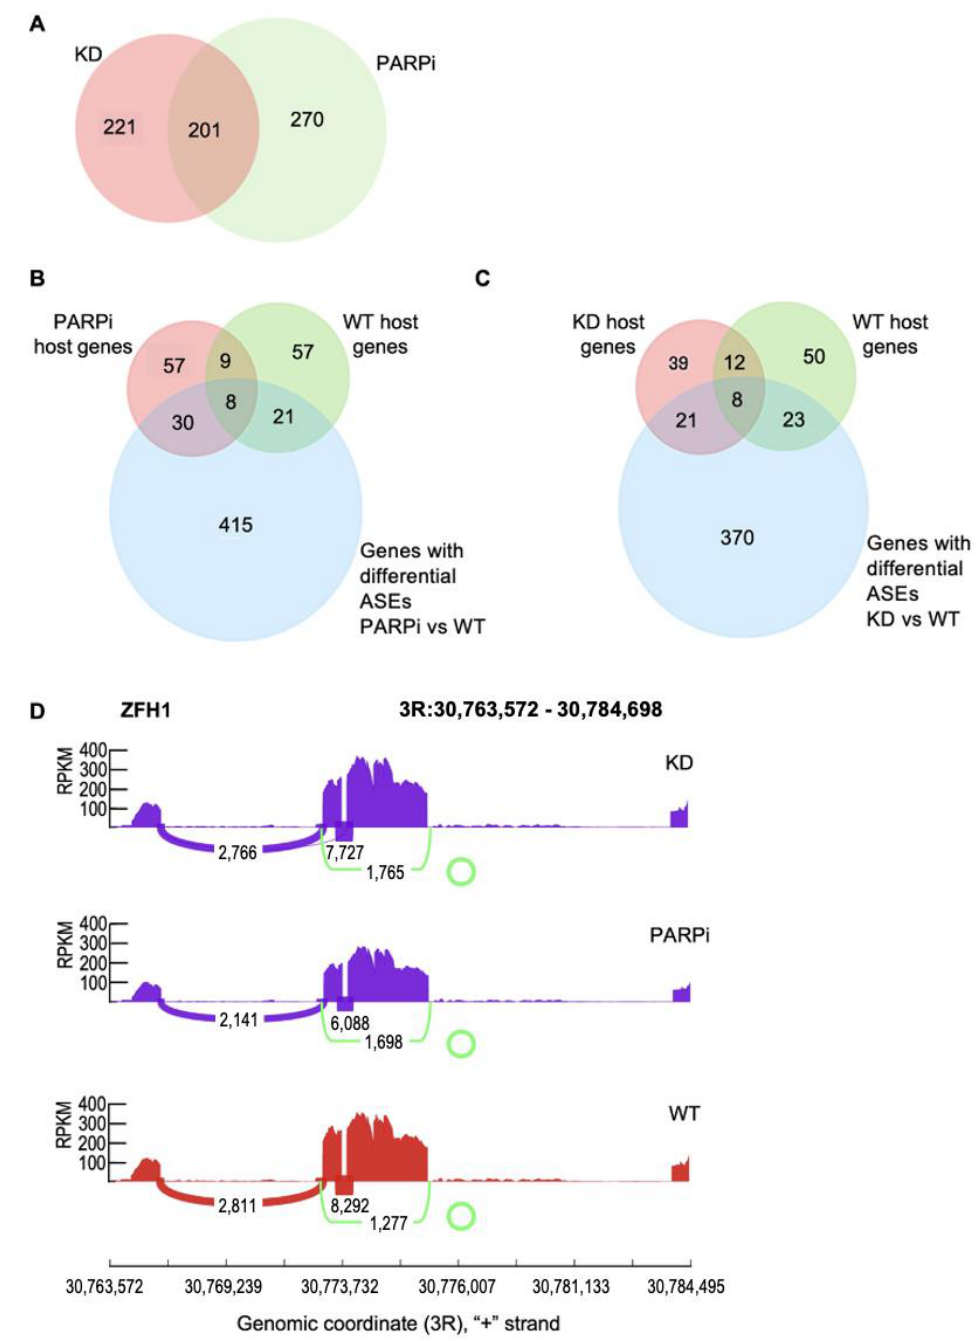
Figure 3. Global alternative splicing events mediated by PARP1 and PARylation. ( A ) Venn diagram showing the differentially spliced genes detected by MATS in PARP1 knockdown compared to PARylation inhibition (PARPi). ( B ) Venn diagram of the host genes of the circRNAs generated in WT and PARPi over the differentially spliced events in PARPi compared to WT conditions ( p < 0.01, by Student’s t -test). ( C ) Venn diagram of the host genes of the circRNAs generated in WT and PARP KD over the differentially spliced events in PARP1 KD compared to WT conditions. PARP1-mediated ASEs (alternative splicing events) detected by rMATs ( p < 0.01, by Student’s t -test). ( D ) Sashimi plots of one example of a host gene, ZFH1, showing alternative splicing events and circRNAs formed in each